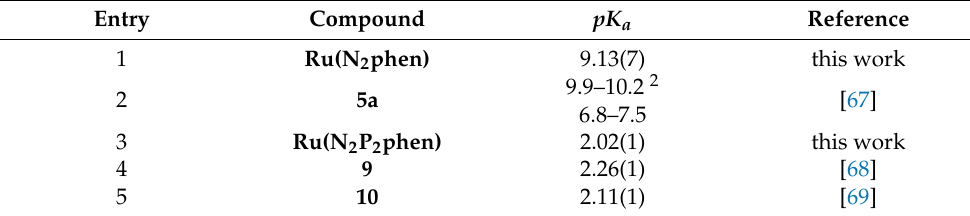
Table 3. Apparent protonation constants or pK a of Ru(N 2 phen), Ru(N 2 P 2 phen) , 5a , 9 , and 10 1 .